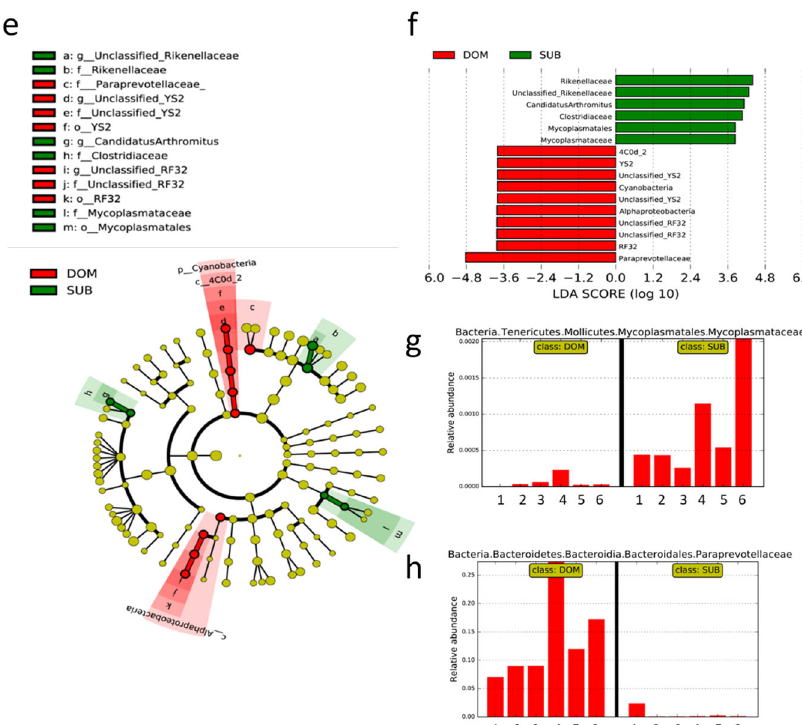
Fig. 4 Gut microbiota compositions and unique taxa in Dom, Sub, and BS mice. a Alpha diversity of the gut microbiome of Dom, Sub, and background-strain (BS) mice ( n = 20; SD = 26.10, 48.44, and 60.15, respectively). The alpha diversity of BS and Dom mice was not signi fi cantly different. b A principal component analysis showing the clustering of the gut microbiome of mice with the same social behavior phenotype. c A heatmap of the 100 most variant species identi fi ed; taxa with similar distributions are grouped together. d Relative abundance up to the genus level. e Cladogram of gut microbiota in the different mouse groups. The taxonomic levels are represented by rings, with the class in the outermost ring and the phylum in the innermost ring. Each ring represents a member within that level. Dom and Sub mice are colored in red and green, respectively. f The LDA scores of biomarkers found by LEfSe to be signi fi cantly different between Dom and Sub mice. Each bar represents the log10 effect size for each taxon. g , h Abundance histograms of the Mycoplasmataceae ( g ) and Paraprevotellaceae ( h ) biomarkers detected by LEfSe. Each bar represents the relative abundance of the speci fi ed taxa in an individual mouse. Statistical signi fi cance was assessed by using a one-way ANOVA with Bonferroni correction, * p < 0.05. Error bars show standard